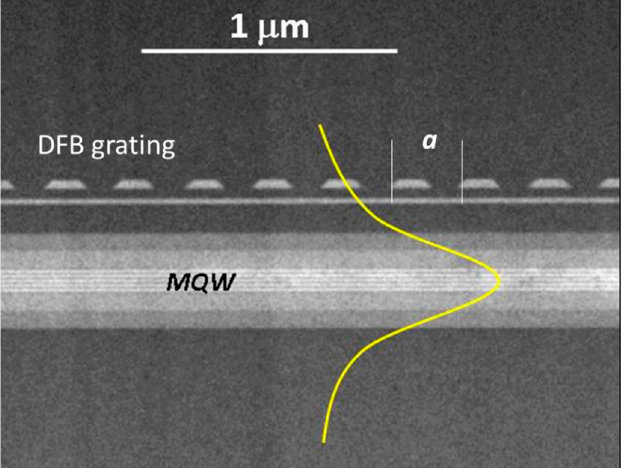
Figure 17. Longitudinal cross-sectional TEM image of the active layer and the surrounding structure in a DFB laser diode. The yellow curve indicates graphically the expected distribution of the optical intensity.